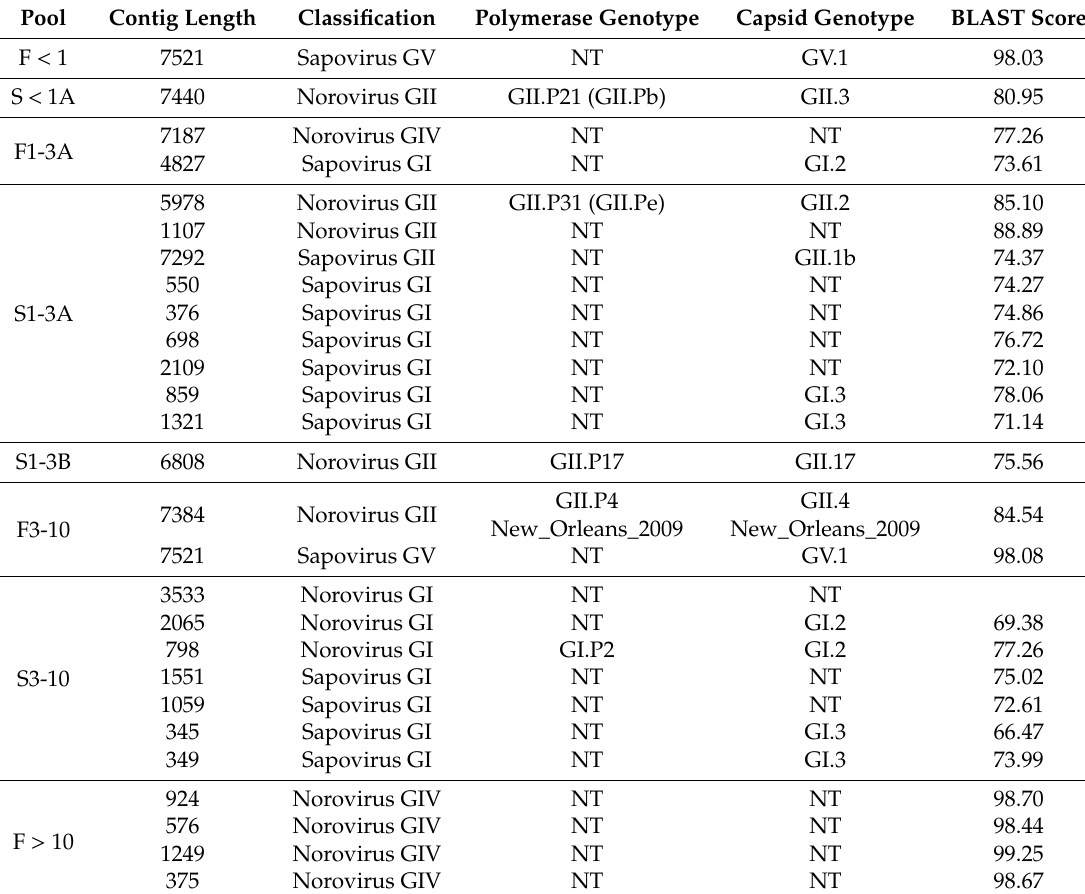
Table 2. Characterization of Caliciviridae contigs detected in the gastroenteritis pools with the